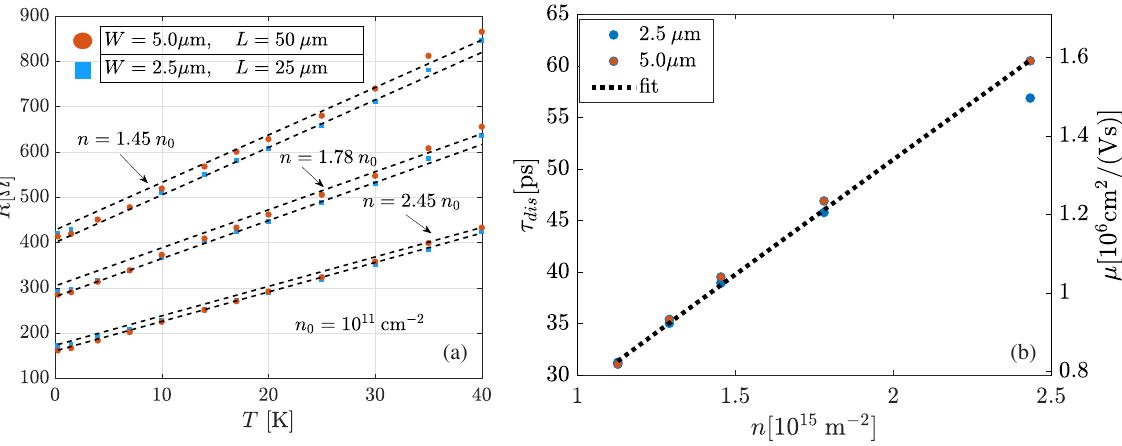
FIG. 4. (a) The resistances in the straight devices with dimensions W ¼ 2 . 5 and 5 . 0 μ m and L ¼ 25 and 50 μ m, respectively, as a function of the temperature. The dotted lines are the high and low fits (see Table II). (b) Electron-impurity mean free time and corresponding impurity limited mobility (at T ¼ 0 . 25 K) with respect to number density. A volumetric distribution of n 10 15 cm − 3 impurities yields the dotted line based on Eqs. (B1) and (B2) and explains the observed data shown by filled